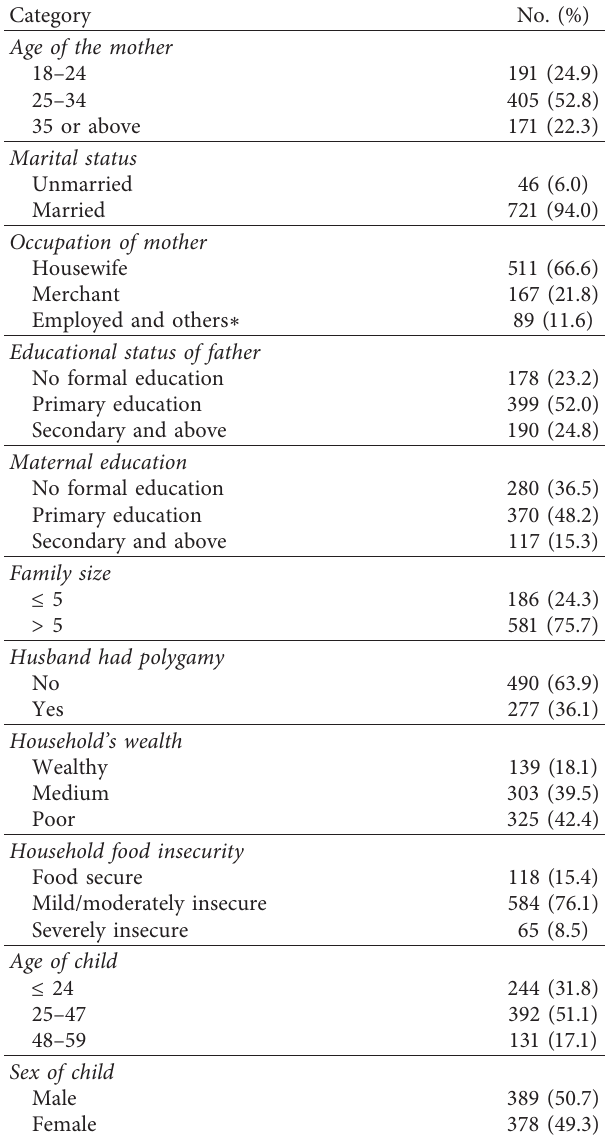
Table 1: Sociodemographic characteristics of respondents,